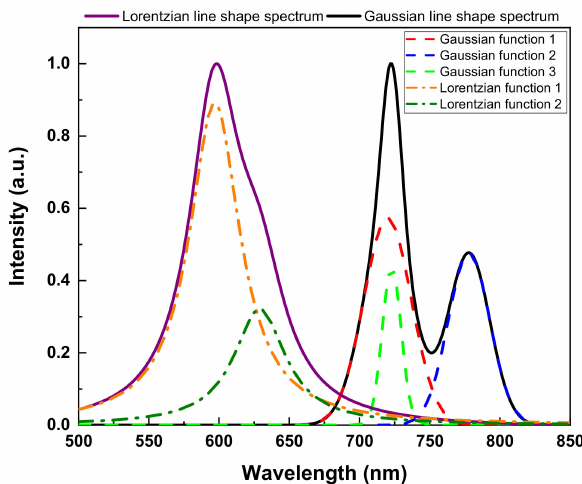
Figure 4. Examples of two synthetic spectra: the solid purple line is composed of two Lorentzian distribution functions (dash-dotted orange and olive lines), and the solid black line is composed of three Gaussian distribution functions (dashed red, blue, and green lines).